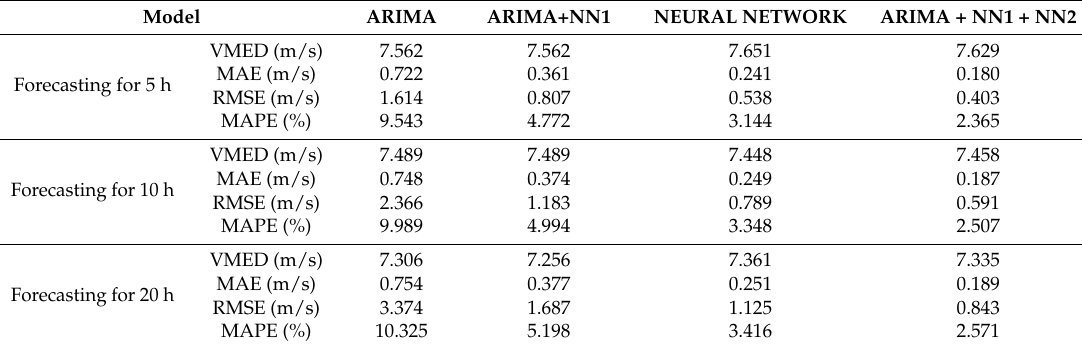
Table 4. Results of errors for multi-season forecast short-term (hours).